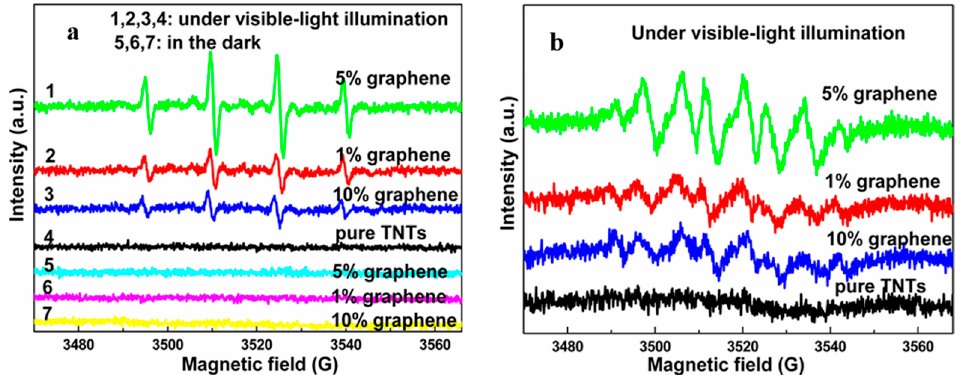
Figure 10. Relationship between mass fraction of graphene and output of the free radicals ( a ) DMPO- OH · and ( b ) DMPO- O (cid:2870)(cid:2879) . Reproduced with permission from [14]. Copyright, Elsevier,